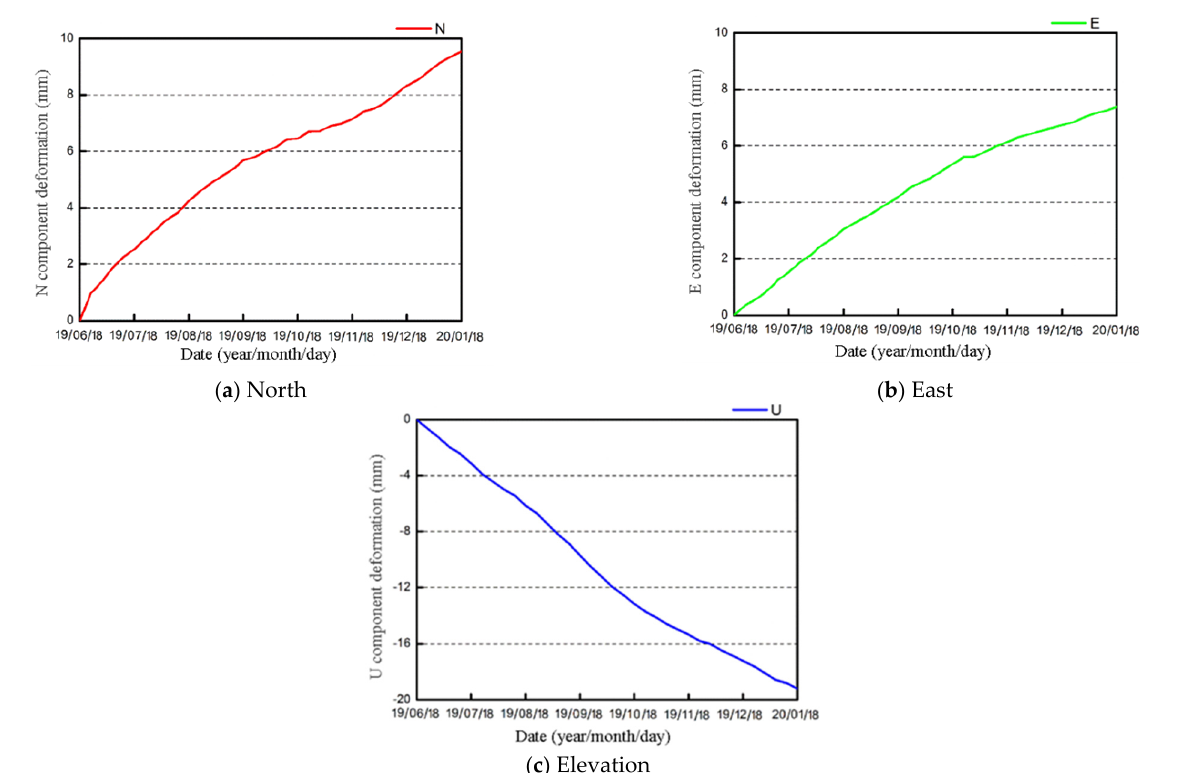
Figure 10. Cumulative shape variables of monitoring points.